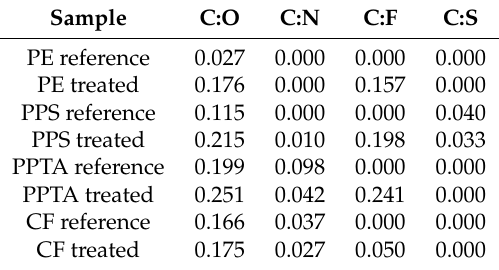
Table 2. Changes of chemical structure after (oxy-)fluorination shown by XPS measurements. All high-performance fibers were prepared with Recipe 2, except CF (Recipe